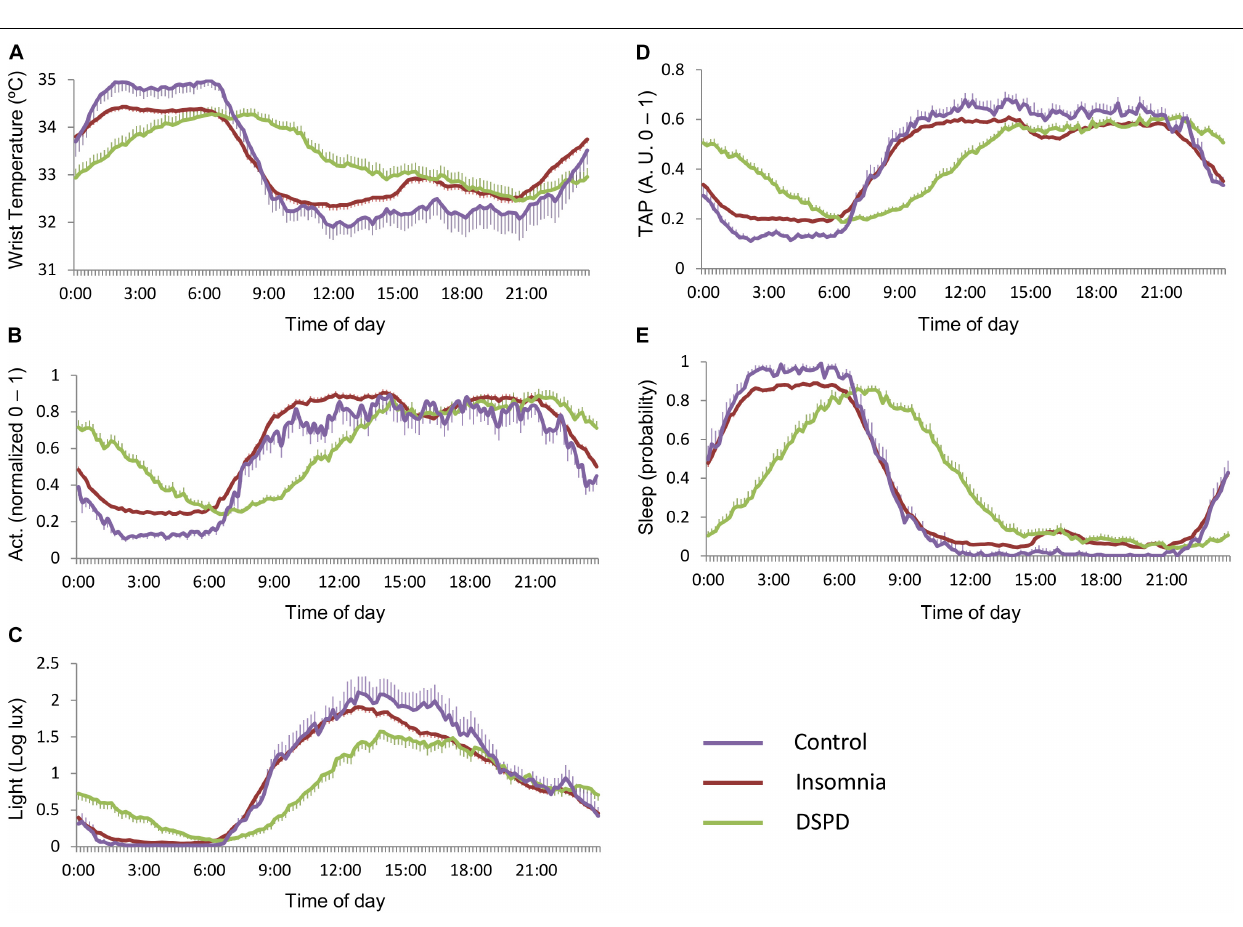
FIGURE 3 | Mean circadian waveforms for (A) wrist temperature, (B) motor activity, (C) environmental light, (D) TAP, and (E) estimated sleep probability of the three main classes: healthy controls (purple), insomnia (red), and DSPD (green). Data are expressed as mean ±